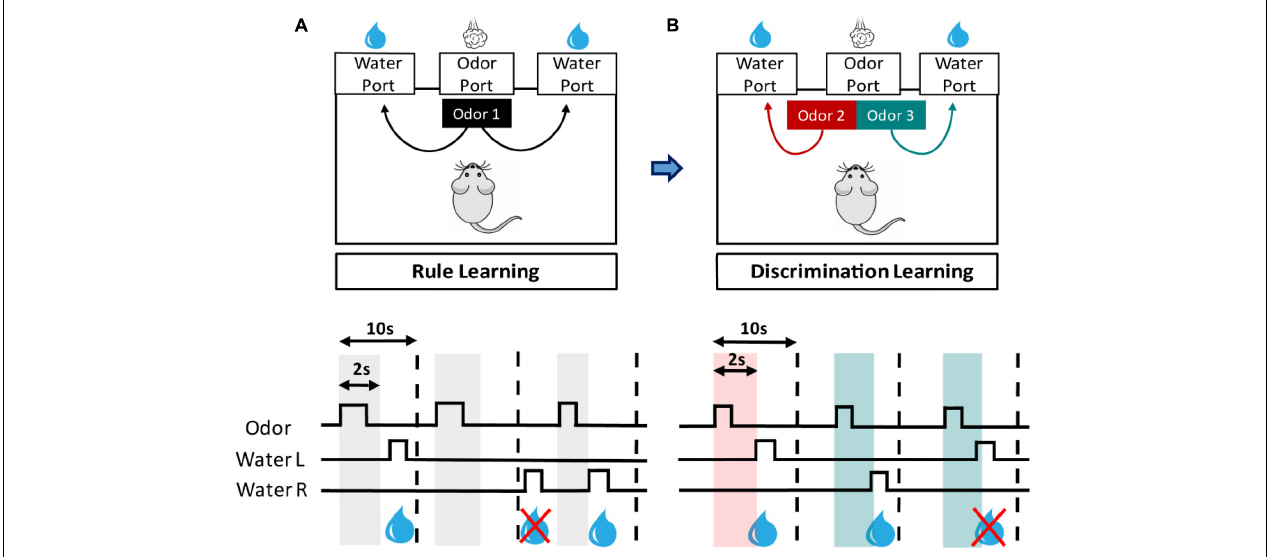
FIGURE 1 | Design of olfactory two-alternative choice task. This task is composed of stepwise training stages for rule learning and discrimination learning. (A) In rule learning, the mouse is trained to learn that poking its nose into central (odor) port and subsequently into left or right side (water) port will be rewarded with water. Nose-poke events are detected by an infrared system installed in each port, and signals are continuously recorded by the computer. (A, lower panel) A trial begins when the mouse pokes its nose into odor port (square waves of odor trace) and that triggers a 2-s odor cue (gray vertical bars) from the port. If the mouse then pokes into left or right water port (square waves of Water L and R traces) within a 10-s window (vertical dashed lines) will trigger a reward of 15 µ l water. (B) When reaching the criteria for rule learning, the mice proceed to the training for discrimination learning, in which two odor cues are provided, and each has an associated water port. (B, lower panel) In a trial of discrimination learning, two odor cues are randomly given (red and green vertical bars). The mouse has to recognize the cue type and enter the correct water port within the time window to receive a water